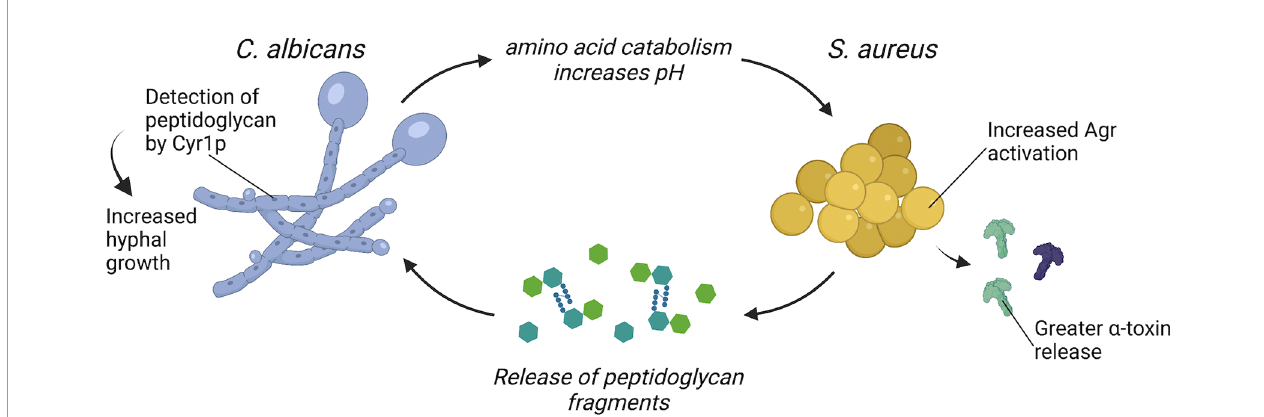
FIGURE 1 | C. albicans and S. aureus interact to enhance virulence. C. albicans enhances S. aureus Agr activation through amino acid metabolism-driven pH modi fi cation and morphogenesis signaling. S. aureus may enhance C. albicans virulence through the release of peptidoglycan fragments that are sensed by Cyr1p and trigger